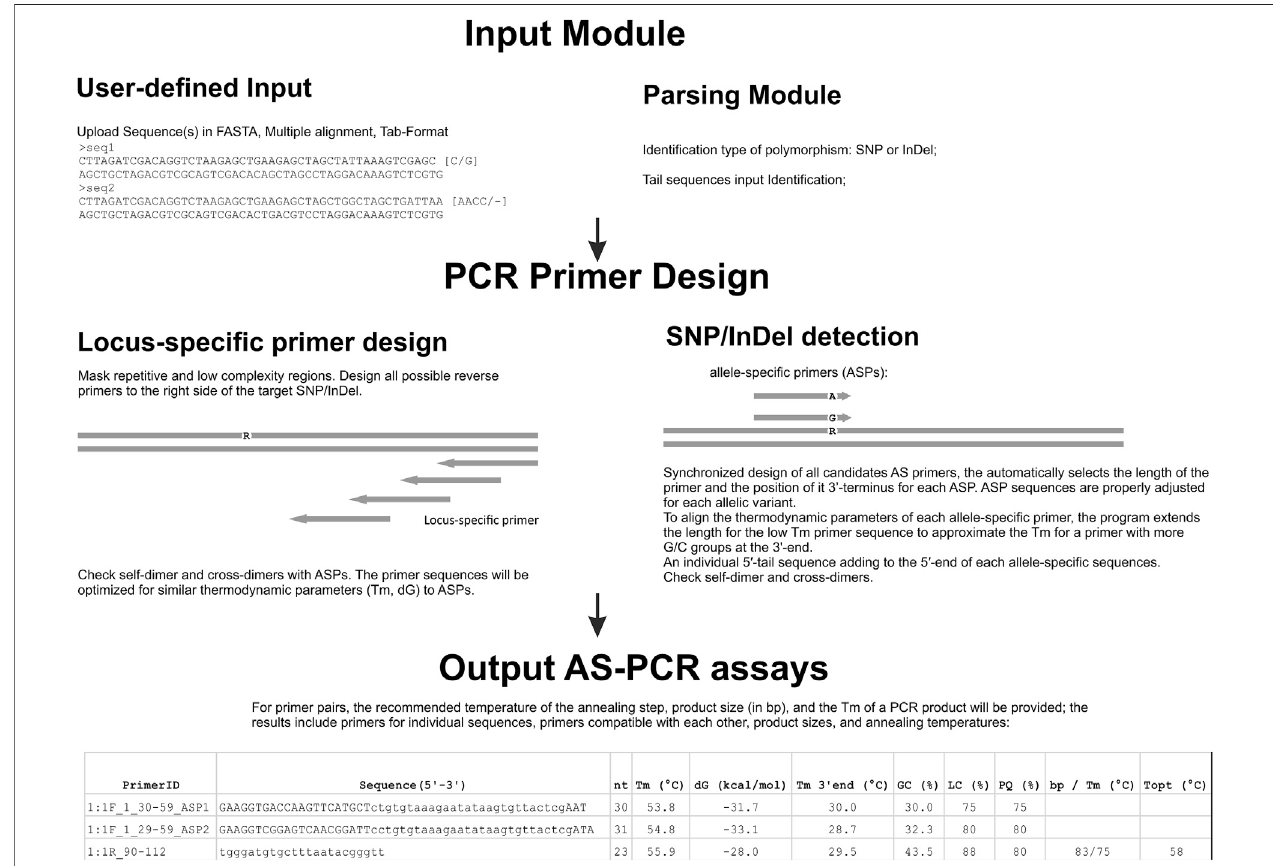
FIGURE 2 | Flowchart of the main steps in the AS-PCR process. Data can be uploaded into FastPCR, which accepts a single sequence or multiple separate DNA sequences in FASTA, tabulated format, multiple alignment, or from clipboard. SNP sequence data are pre-processed by FastPCR prior to execution to collect the SNP positionandalsotoremovenon-DNAsymbolsfromtheentiresequence.TheusersetsthevariousparametersforprimerdesignfortheDNAorSNPsequences,suchas primer maximum and minimum lengths and T m . Repetitive or low-complexity sequences are excluded from primer design by default (this can be changed by the user). The initial primer design attempts both directions and a reverse primer is designed at the upstream accordingly. An allele-speci fi c primer with the SNP site is designed at the second (penultimate) position of the primer ’ s 3 ′ terminus or to any other position in manual or automatic mode. Once the allele-speci fi c primers are designed,an individual5 ′ -tail sequence isadded tothe5 ′ end ofeach allele-speci fi csequence.Thiscombinedwholeprimersequence isreanalysed forself- and cross- dimerization. Finally, results are returned to the text-editor